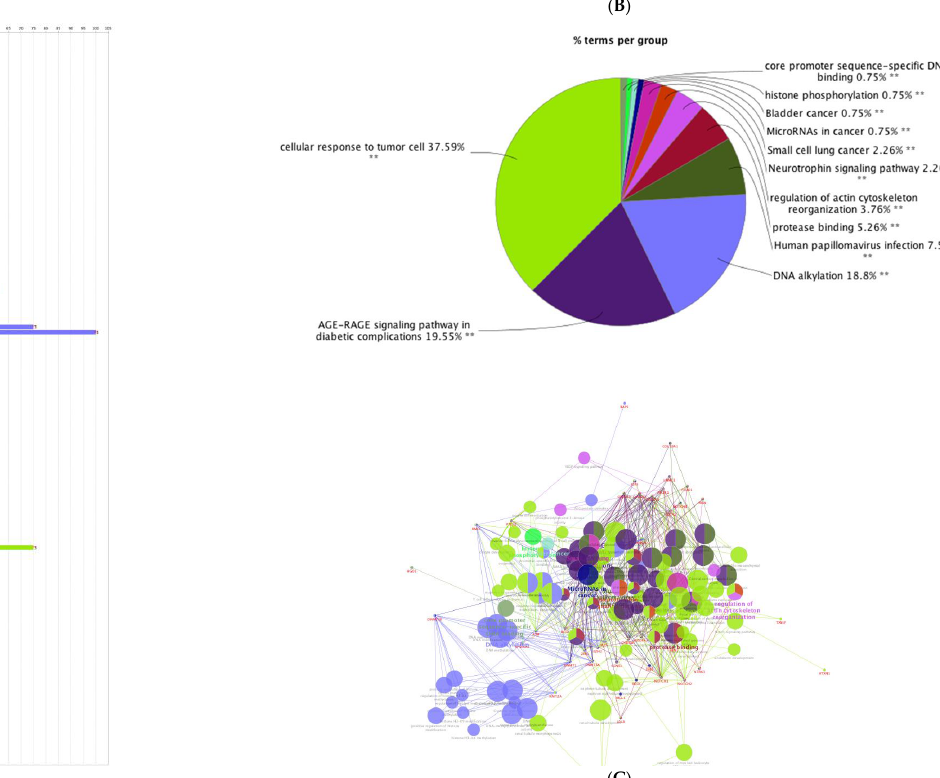
Figure 5. ClueGO analysis of down regulated genes in sperm and seminal plasma from high- fertile bulls. ( A ) GO/pathway terms specific for down regulated genes. The bars represent the number of genes associated with the terms. The percentage of genes per term is shown as bar label; ( B ) overview chart with functional groups including specific terms for down regulated genes; ( C ) functionally grouped network with terms as nodes linked based on their kappa score level ( ≥ 0.4), where only the label of the most significant term per group is shown. The node size represents the term enrichment significance. Functionally related groups partially overlap. The color gradient shows the gene proportion of each cluster associated with the term. Single (*) or double (**) asterisk indicate significant enriched GO terms at the p < 0.05 and p < 0.01 statistical